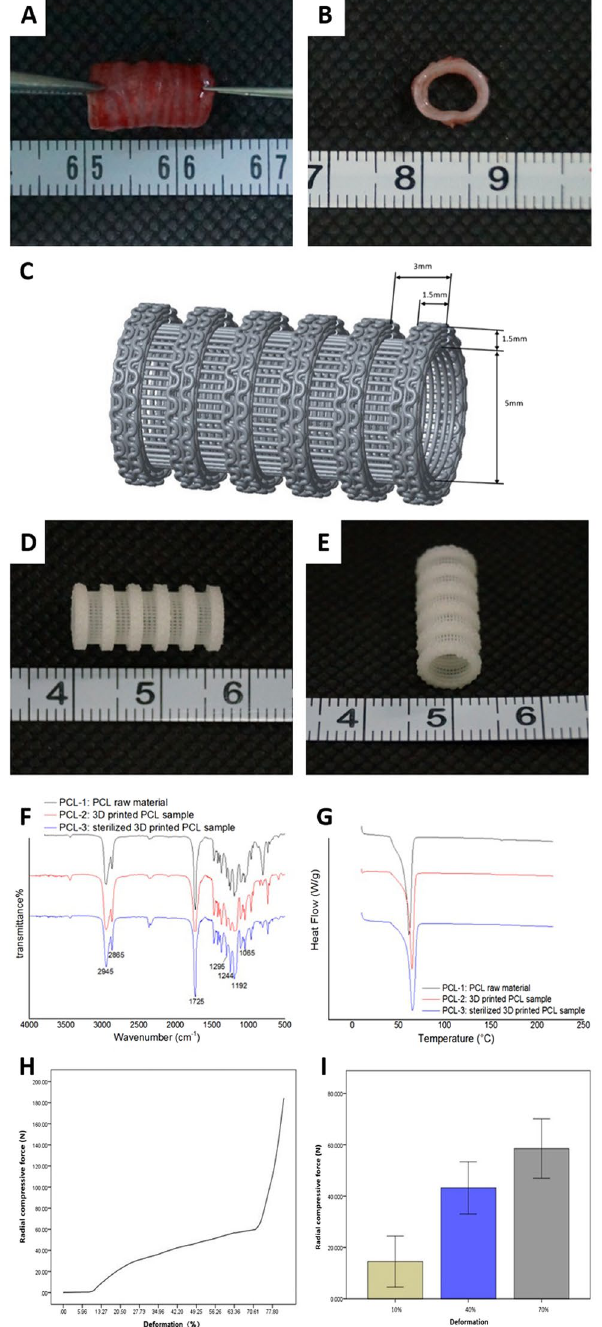
Figure 1. Design of a novel 3D-printed whole trachea from PCL scaffold. ( A and B ) Representative photograph of native trachea extracted from a four-month-old Zealand white rabbit. ( C ) Blueprint design of a 3D printed PCL scaffold. ( D and E ) Representative photograph of a 3D printed PCL scaffold. ( F ) Representative FT-IR spectra of PCL raw material, 3D-printed PCL samples, and sterilized 3D-printed PCL samples. The characteristic peaks for carbonyl stretching is shown at 1725 cm − 1 and spectra present at 1295 cm − 1 reveal the backbone C-C and C-O stretching modes both of which revealed no major differences between the three groups. The asymmetric and symmetric C-O-C stretching can be confirmed by the peaks present at 1244 cm − 1 and 1192 cm − 1 , respectively, and peaks at approximately 1065 cm − 1 are associated with the COH stretching, where again the pattern is maintained across all three groups. ( G ) Differential Scanning Calorimetry (DSC). Results indicate same amount of heat is required to raise the temperature of the PCL raw material, 3D-printed PCL samples, and sterilized 3D-printed PCL. ( H ) Representative radial compressive force-deformation curve of scaffold. ( I ) Average radial compressive force highlighting 10%, 40% and 70% deformation (n =